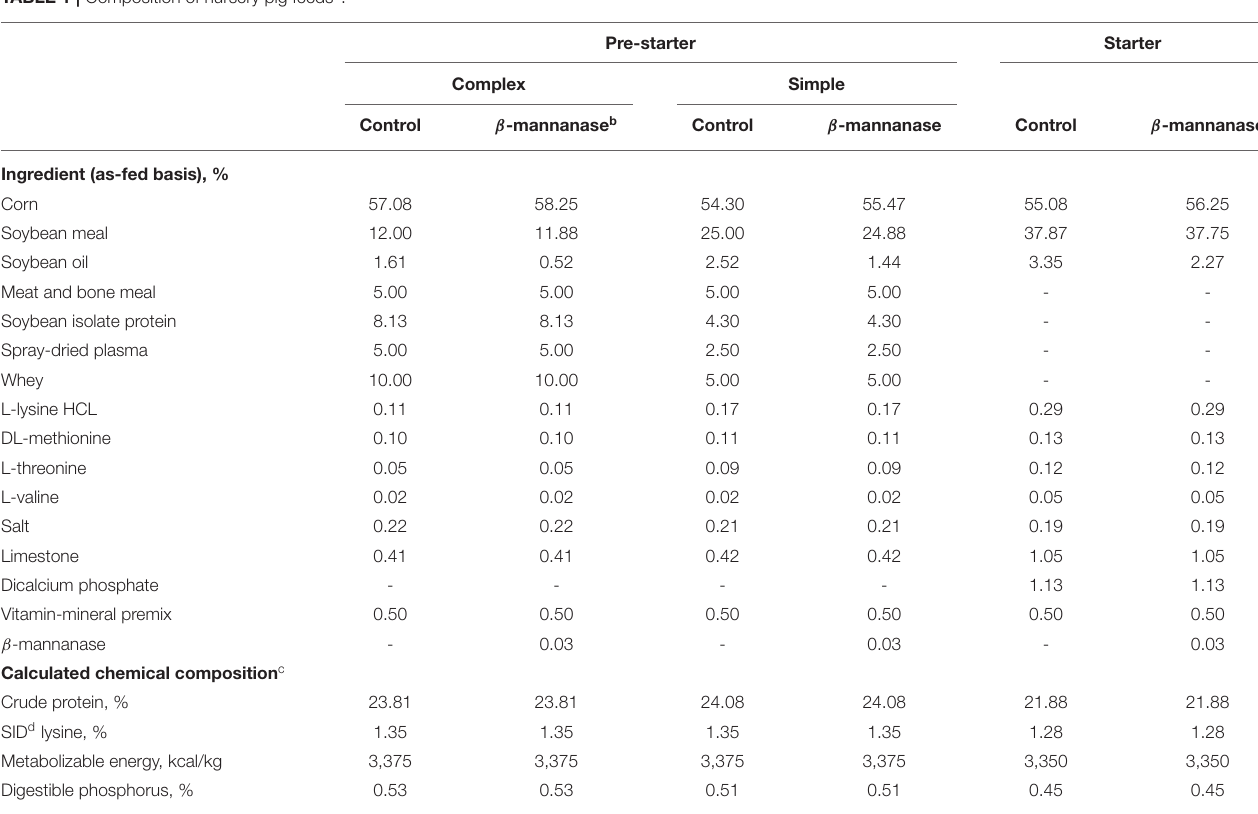
FIGURE 1 | Flowchart of the pig and poultry feeding programs being assessed through life-cycle assessment standards. Crop inputs, crop production, β -mannanase production, production of the other feed ingredients, drying, processing, storage, transportation, and feed production were the main processes considered, with system boundaries including all sub-processes. TABLE 1 | Composition of nursery pig feeds a